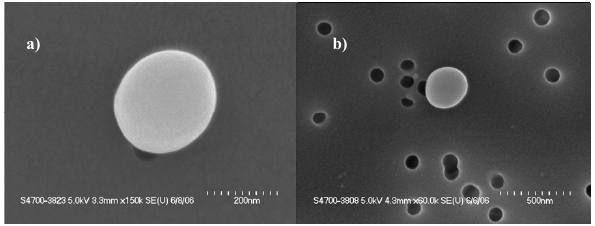
Fig. 2. Scanning electron microscopy (SEM) image of a typical tar ball emitted from smoldering biomass combustion of (a) Ponderosa Pine Duff, and (b) Alaskan Tundra Duff. Electron dispersive spec- troscopy (EDX) of tar balls shows that these particles consist pri- marily of carbon and oxygen with an average molar ratio of about